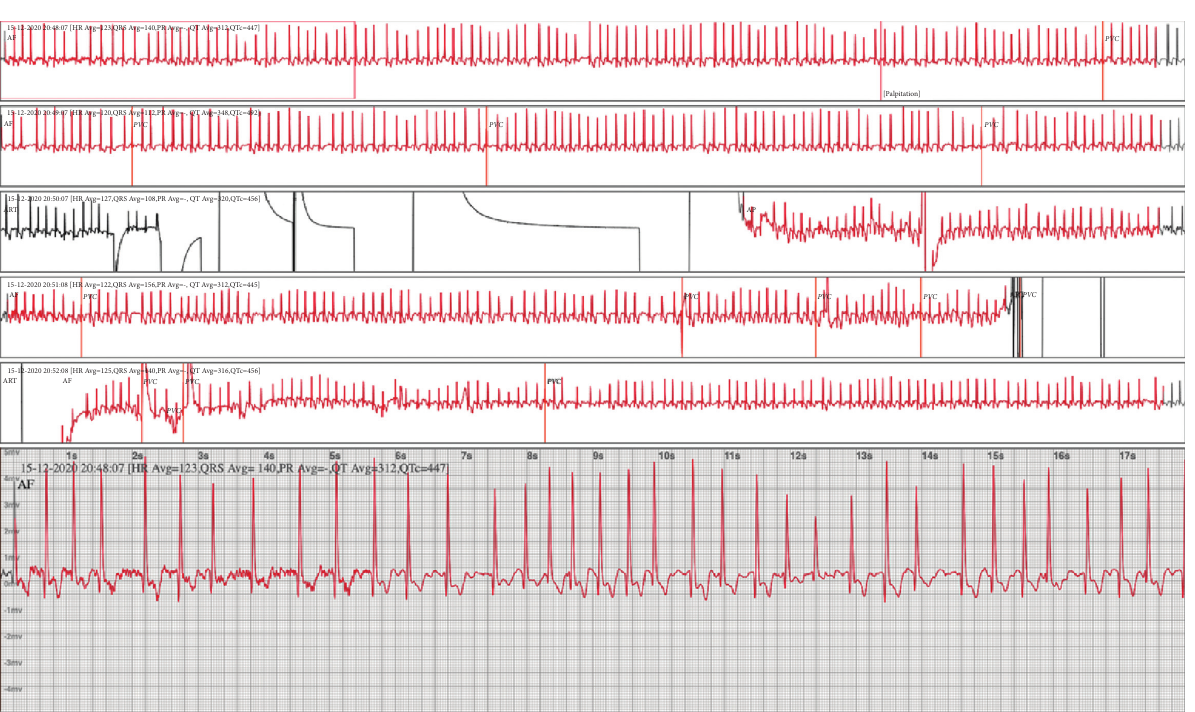
Figure 2: An episode of atrial fibrillation detected by Spyder in a patient with cryptogenic stroke after 28.8 hours of wearing.